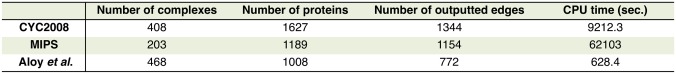
Results with three protein complex datasets.